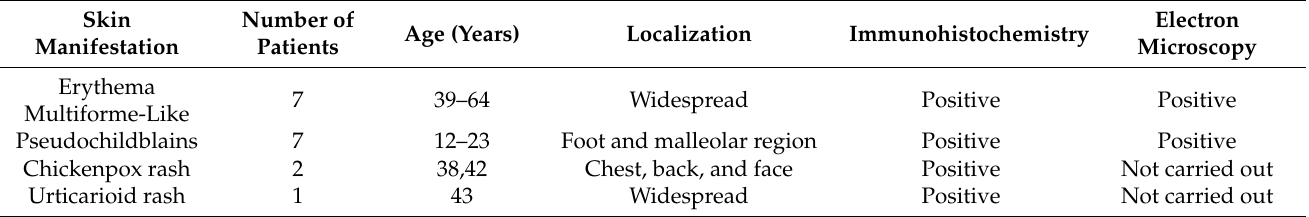
Table 1. Summary of skin manifestations found in our study.